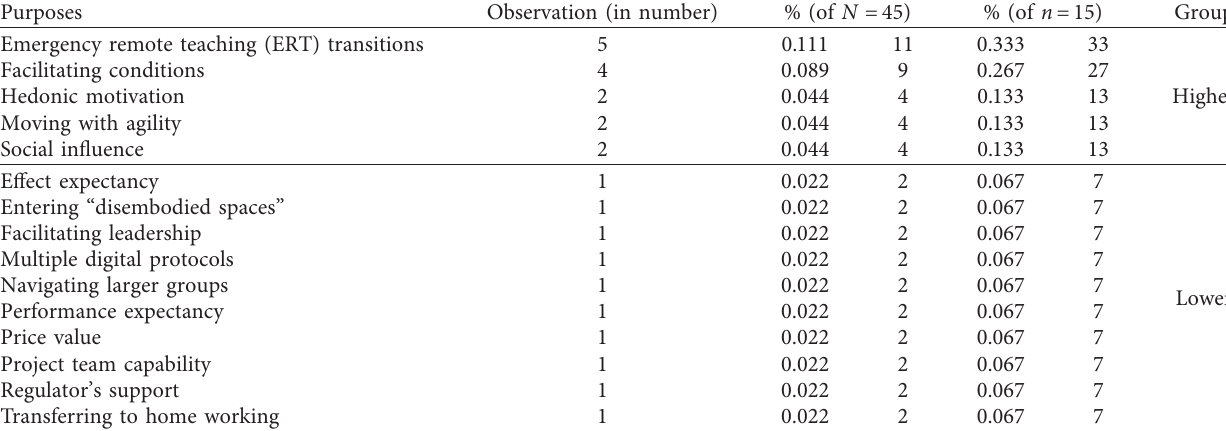
Table 8: Percentage of each purpose of shifting to online learning and their groups based on 50th quartile.